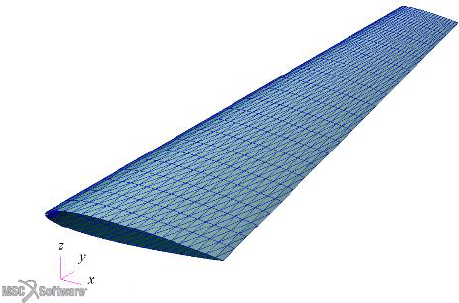
Figure 3. Planform ( left ) and cross section at root ( right ) of the wing model.